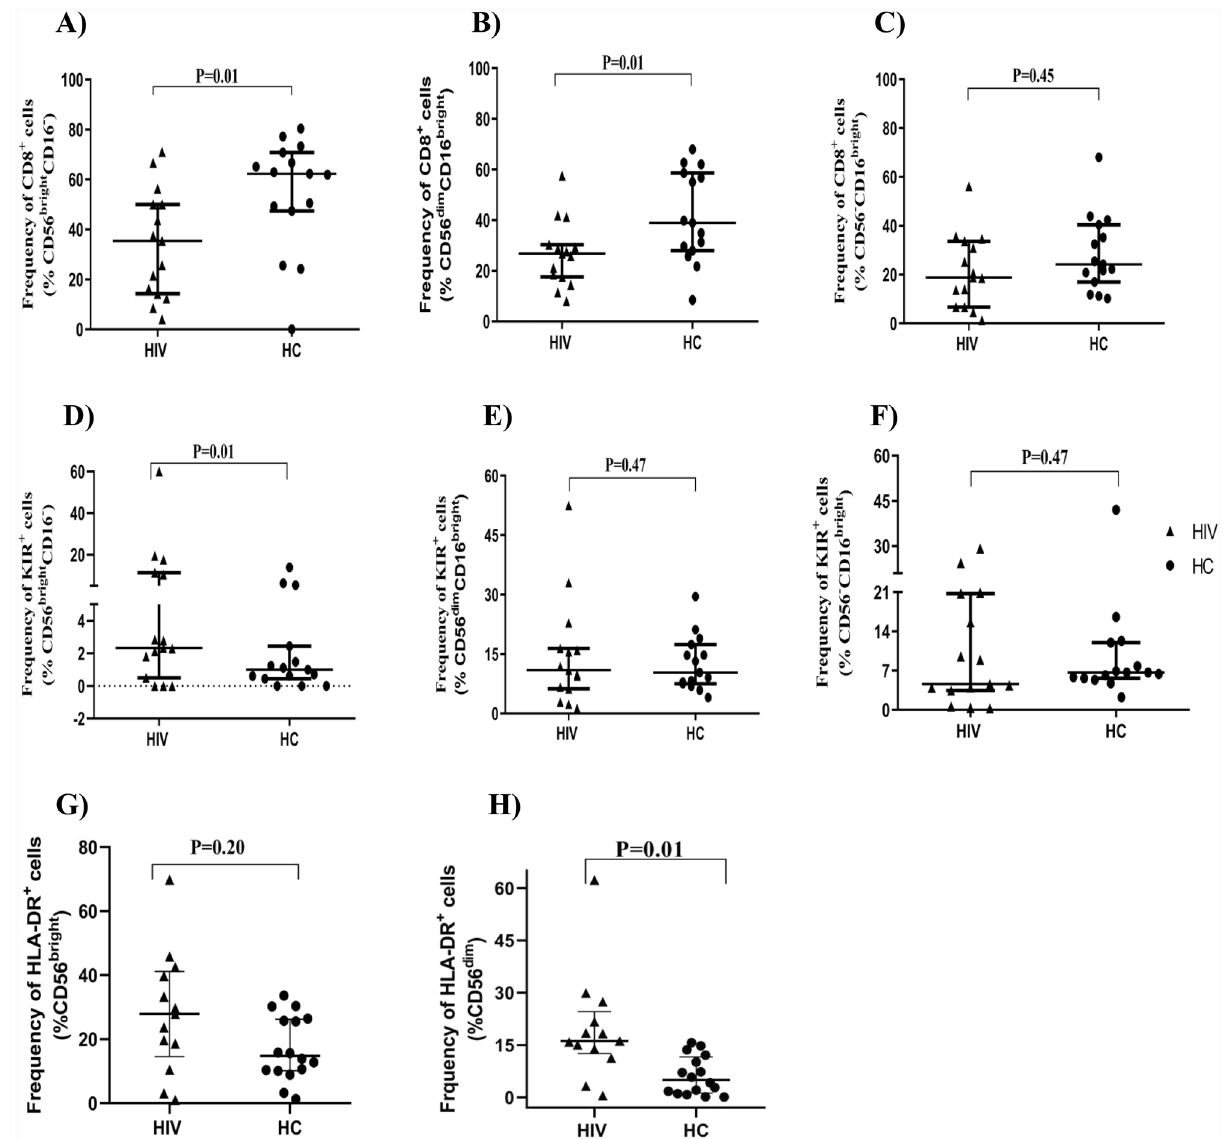
Figure 4. Frequency of KIR3DL1/S1 + , CD8 + and HLA-DR cells among NK cells subsets. The frequency of CD8 + and KIR3DL1/S1 + cells within the CD56 bright CD16 − ve ( A , D ), CD56 dim CD16 bright ( B , E ) and CD56 − ve CD16 bright ( C , F ) subsets are depicted for both HIV (n = 15) and HC groups (n = 15). The frequency of HLA-DR positive cells is shown for CD56 bright ( G ) and CD56 dim ( H ) subsets (n = 13, HIV group, n = 16 HC group). Mann–Whitney tests were performed with a p-value < 0.05 considered statistically significant. The median and 25th and 75th percentile are indicated on each